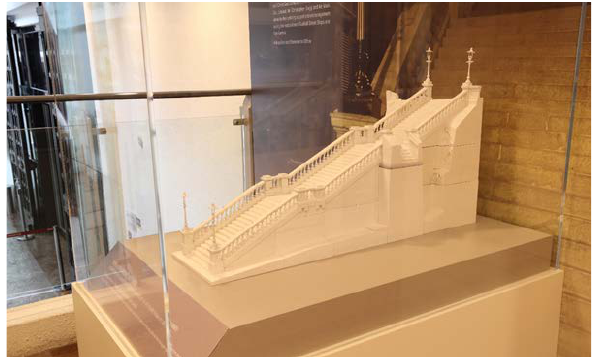
Figure 11: The reassembled Steps model using the 3D printed miniature replicas of numbered granite